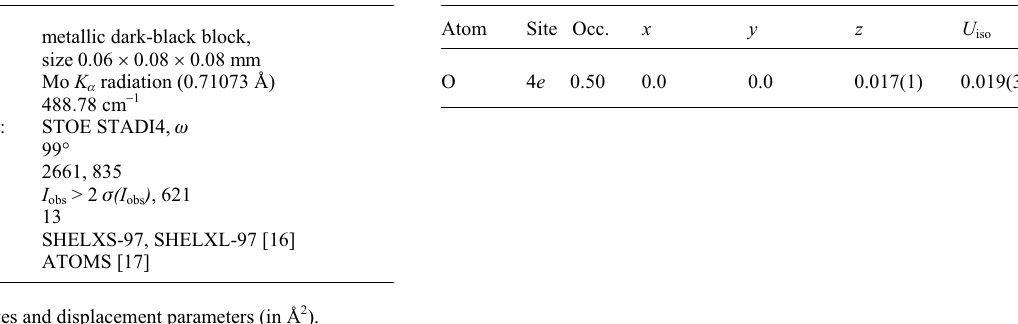
Table 4. Data collection and handling. Table 5. Atomic coordinates and displacement parameters (in Å 2 ) .